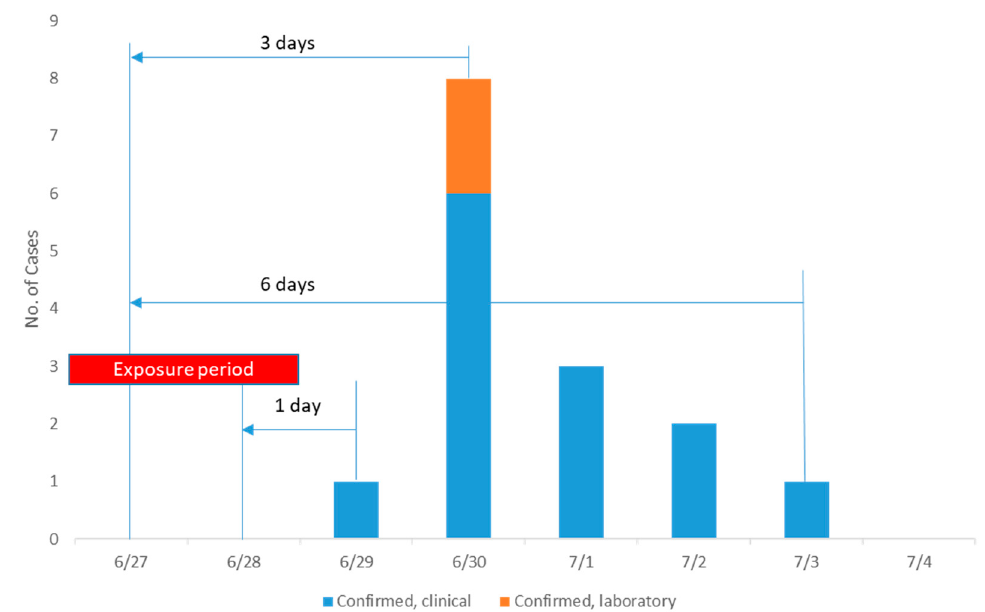
Figure 1. Distribution of food poisoning in clinically confirmed and laboratory-confirmed cases, considering the incubation period.